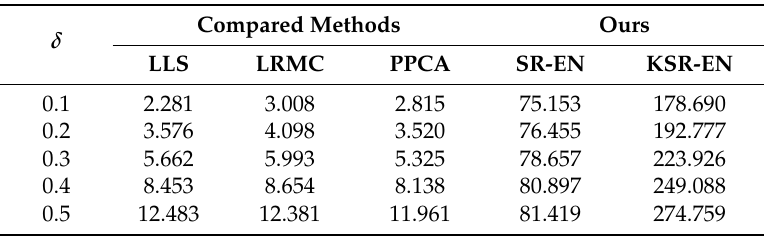
Table 5. Computational time(s) of different